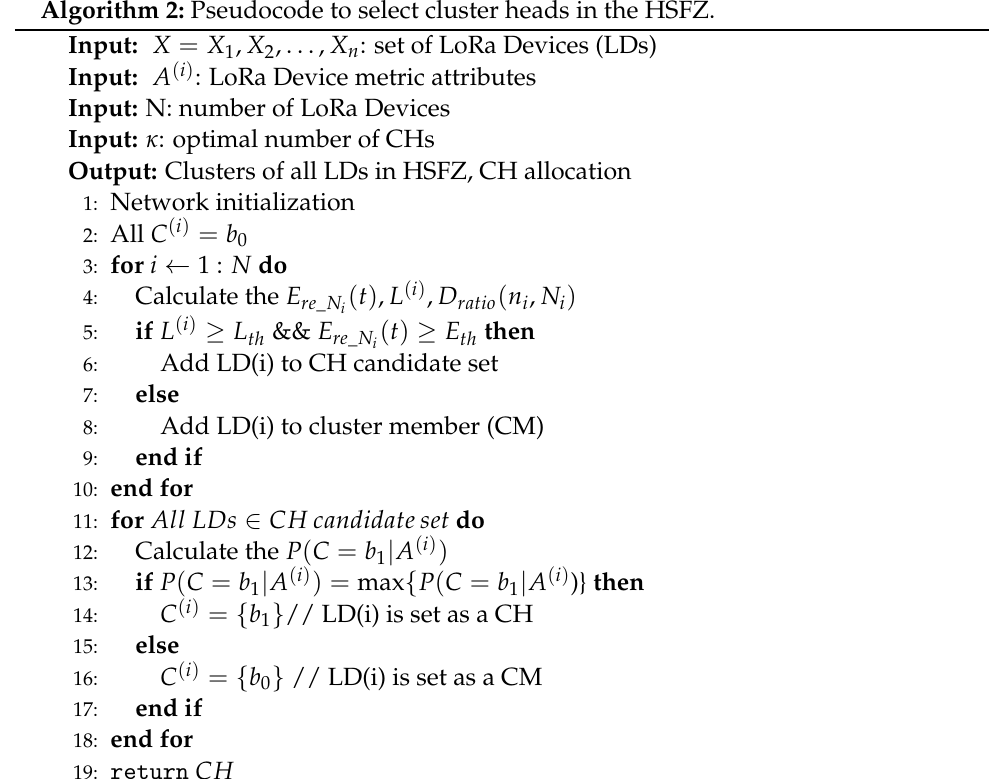
Algorithm 2: Pseudocode to select cluster heads in the